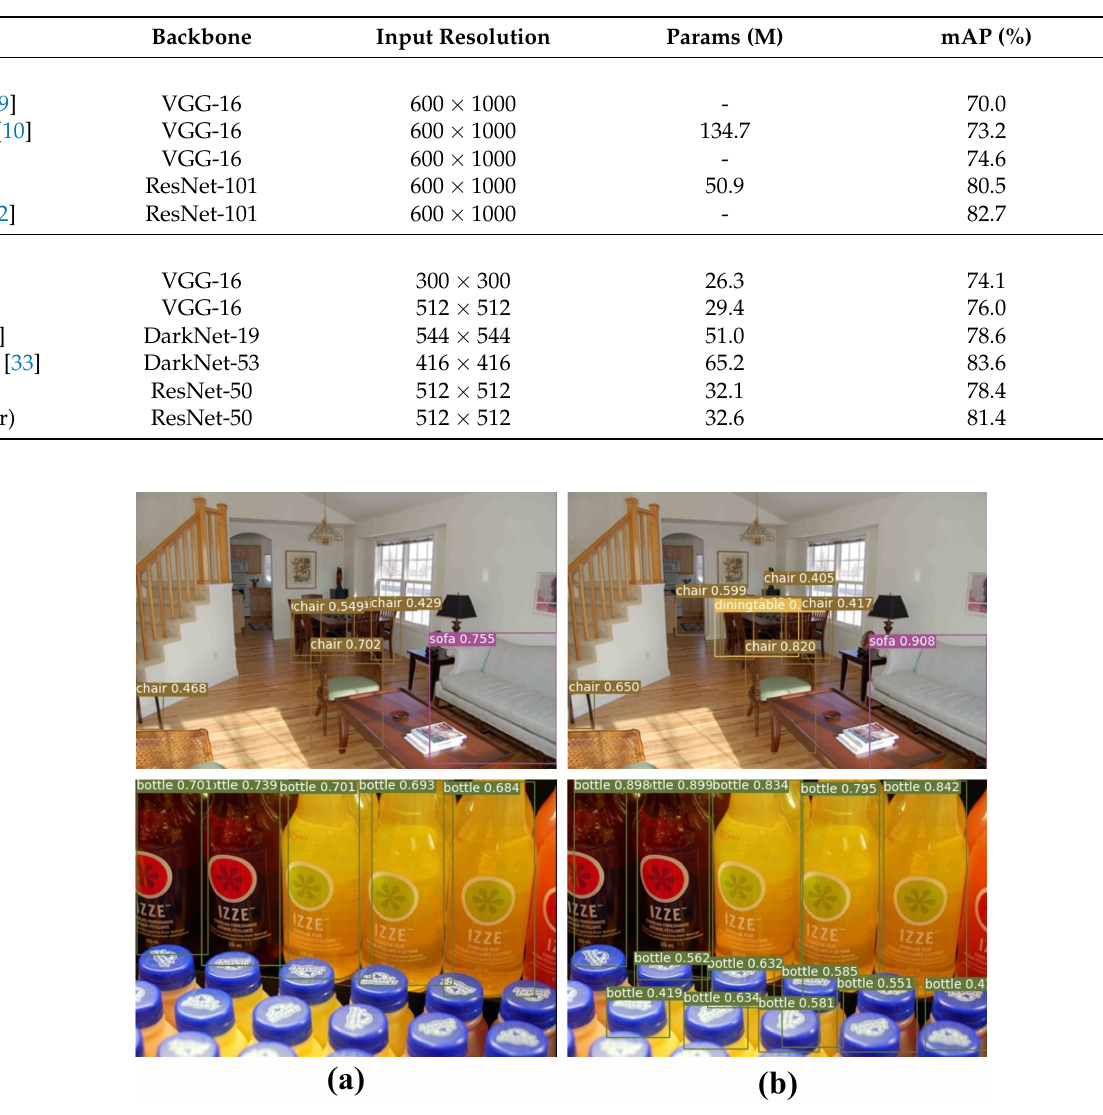
Table 2. Comparison of other networks with PASCALVOC 07 test dataset.